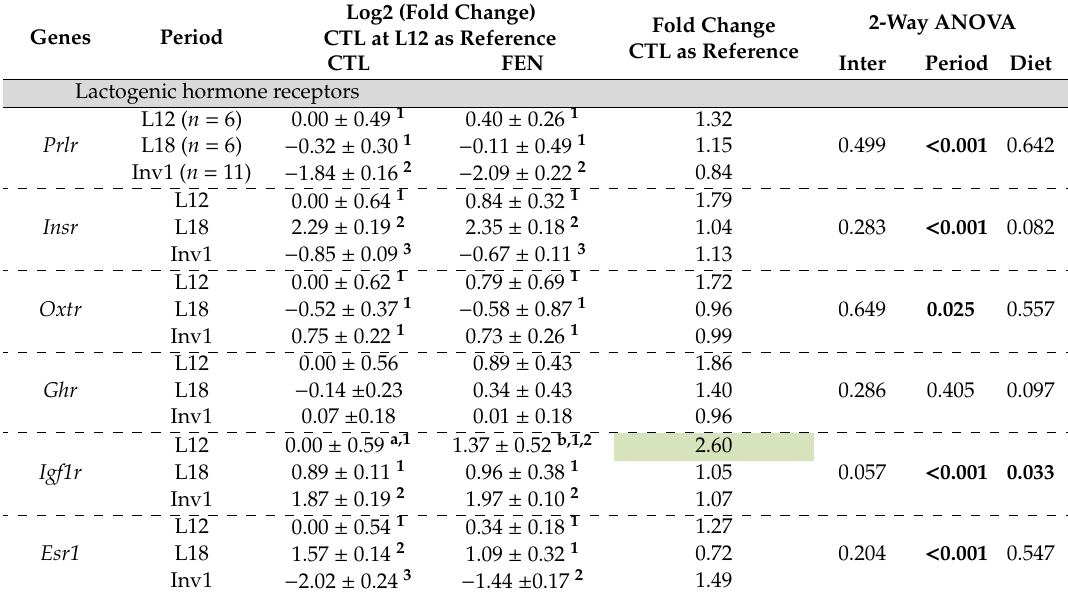
Table 5. E ff ect of fenugreek on relative expression of genes of lactogenic hormone receptors in mammary gland along lactation period. Log2 (Fold Change) Fold CTL at L12 as Reference